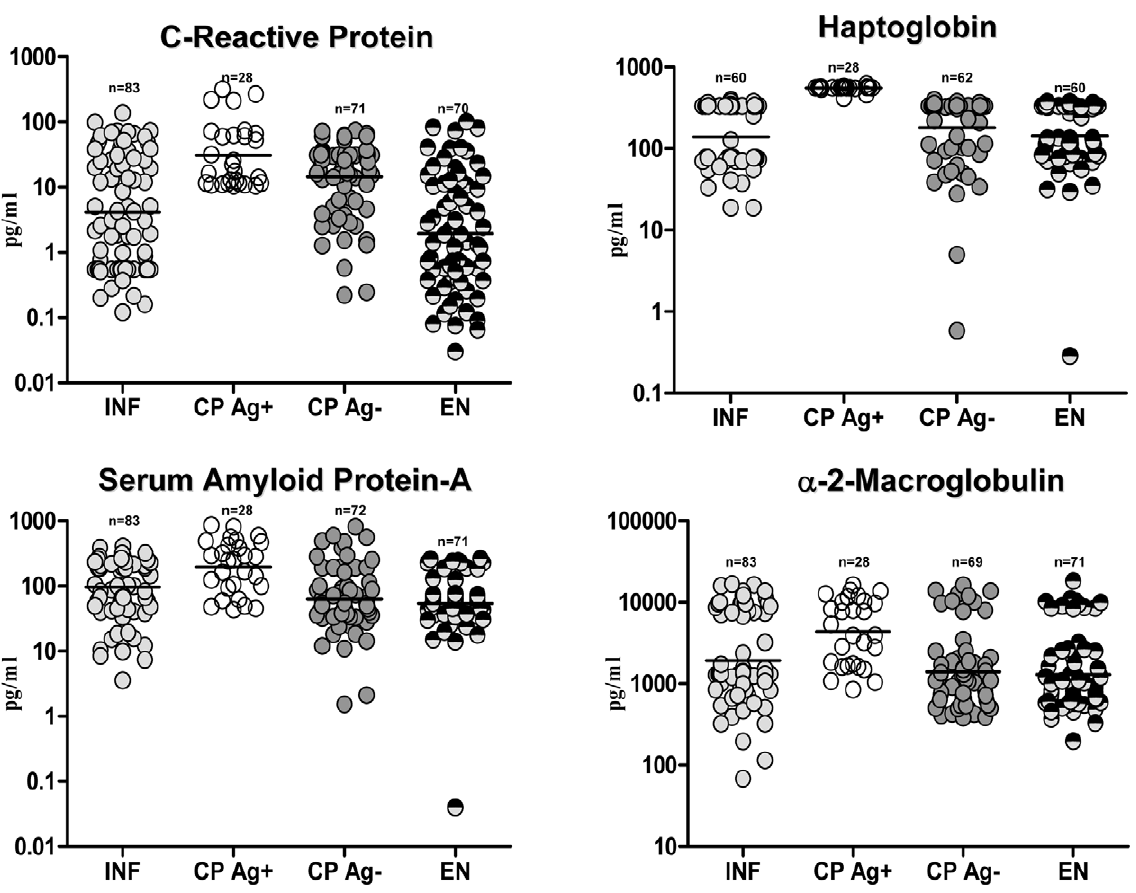
Figure 2. Filarial lymphedema is associated with elevated levels of acute phase proteins. Plasma levels of CRP, Haptoglobin, SAA and a -2 macroglobulin from asymptomatic infected [INF] individuals; filarial lymphedema individuals with active infection [CP Ag + ]; filarial lymphedema individuals without active infection [CP Ag 2 ] and endemic normal [EN] individuals were measured by ELISA. Data are shown as scatter plots with the bar representing the geometric mean.